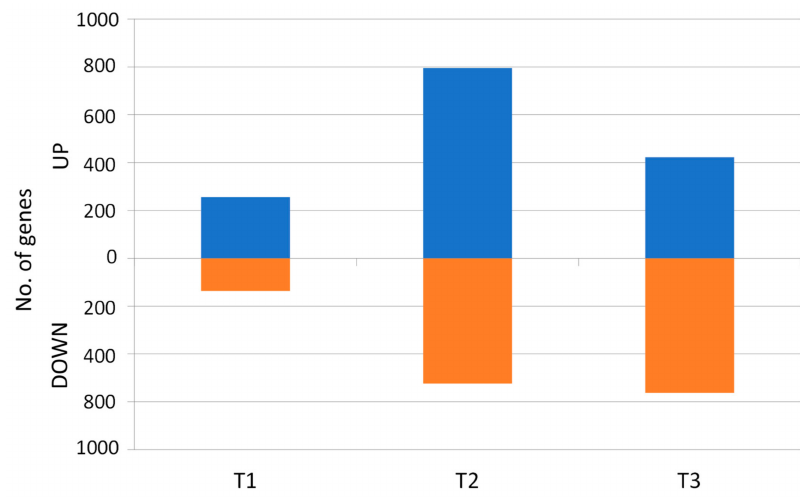
Figure 7. DEGs up- and downregulated (blue and orange bars, respectively) in the cultivated carrot at three timepoints, as related to the wild